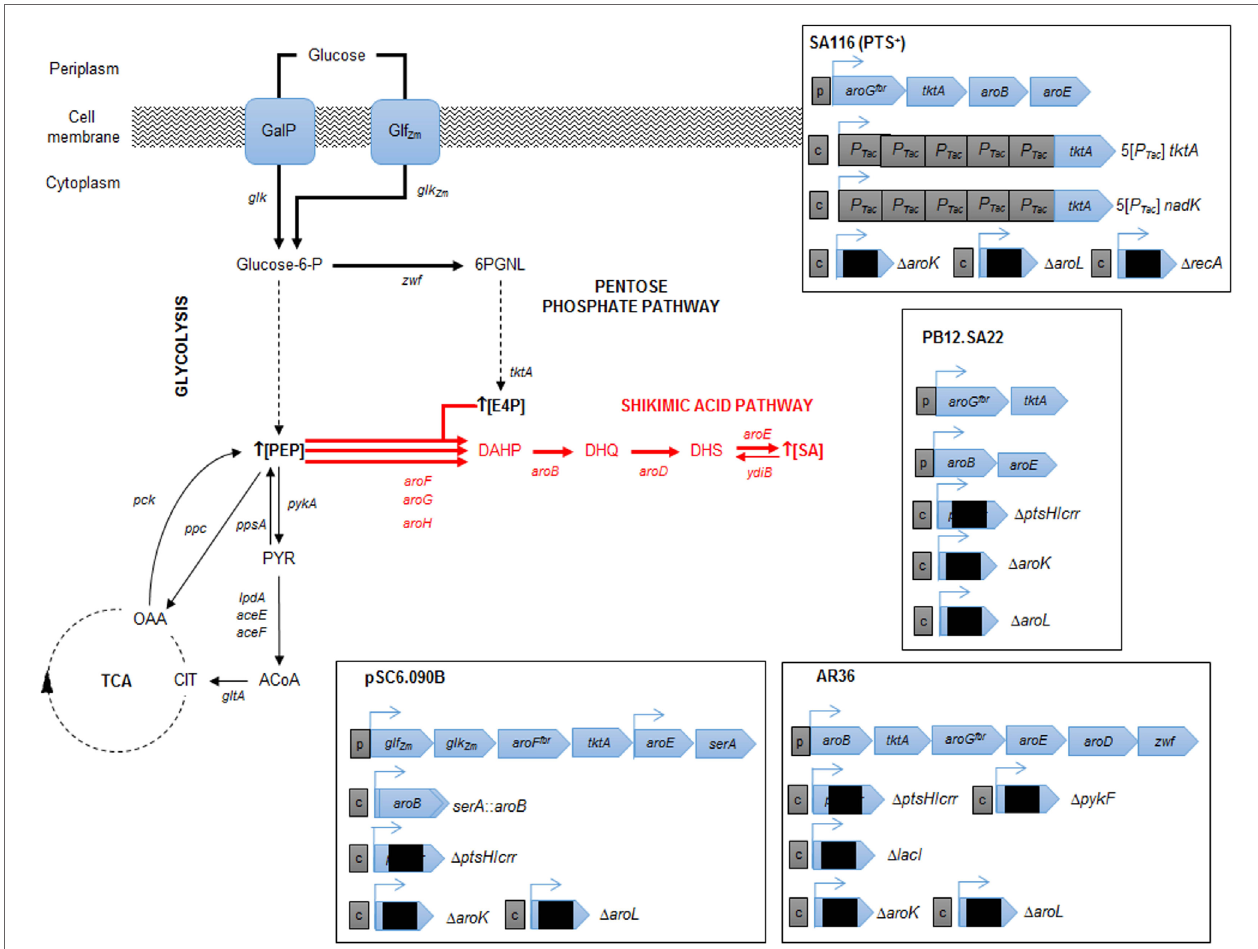
FiGURe 3 | Relevant engineered E. coli strains for SA production . Metabolic traits of E. coli derivative strains engineered for SA production resulting in highest SA titer and yield from glucose. The figure illustrates alterative glucose transporter GalP (galactose permease) selected by the cell after laboratory adaptive evolution process of a PTS − mutant (Flores et al., 1996, 2007; Aguilar et al., 2012). Glf (glucose facilitator) and Glk (glucokinase) from Z. mobilis (plasmid cloned). Resultant characteristics of engineered strains are shown for pSC6.090B (Chandran et al., 2003), PB12.SA22 (Escalante et al., 2010), AR36 (Rodriguez et al., 2013), and SA116 strain (Cui et al., 2014). CCM key intermediates and protein encoding genes: TCA, tricarboxylic acid pathway; E4P, erythrose-4-P; PGNL, 6-phospho d -glucono-1,5-lactone; PEP, phosphoenolpyruvate; PYR, pyruvate; ACoA, acetyl-CoA; CIT, citrate; OAA, oxaloacetate; zwf , glucose 6-phosphate-1-dehydrogenase; tktA , transketolase I; pykA , pyruvate kinase II; lpdA , aceE and aceF , coding for PYR dehydrogenase subunits; gltA , citrate synthase; pck , PEP carboxykinase; ppc PEP carboxylase; ppsA , PEP synthetase. SA pathway intermediates and genes: DAHP, 3-deoxy- d - arabino -heptulosonate-7-phosphate; DHQ, 3-dehydroquinate; DHS, 3-dehydroshikimate; SA, shikimic acid. Continuous arrows indicate single enzymatic reactions; dashed arrows show several enzymatic reactions. Bold arrows show improved carbon flux. Black squares in plasmids/operons indicate gene interruption; c, chromosomal gene interruption or integration; p, plasmid-cloned